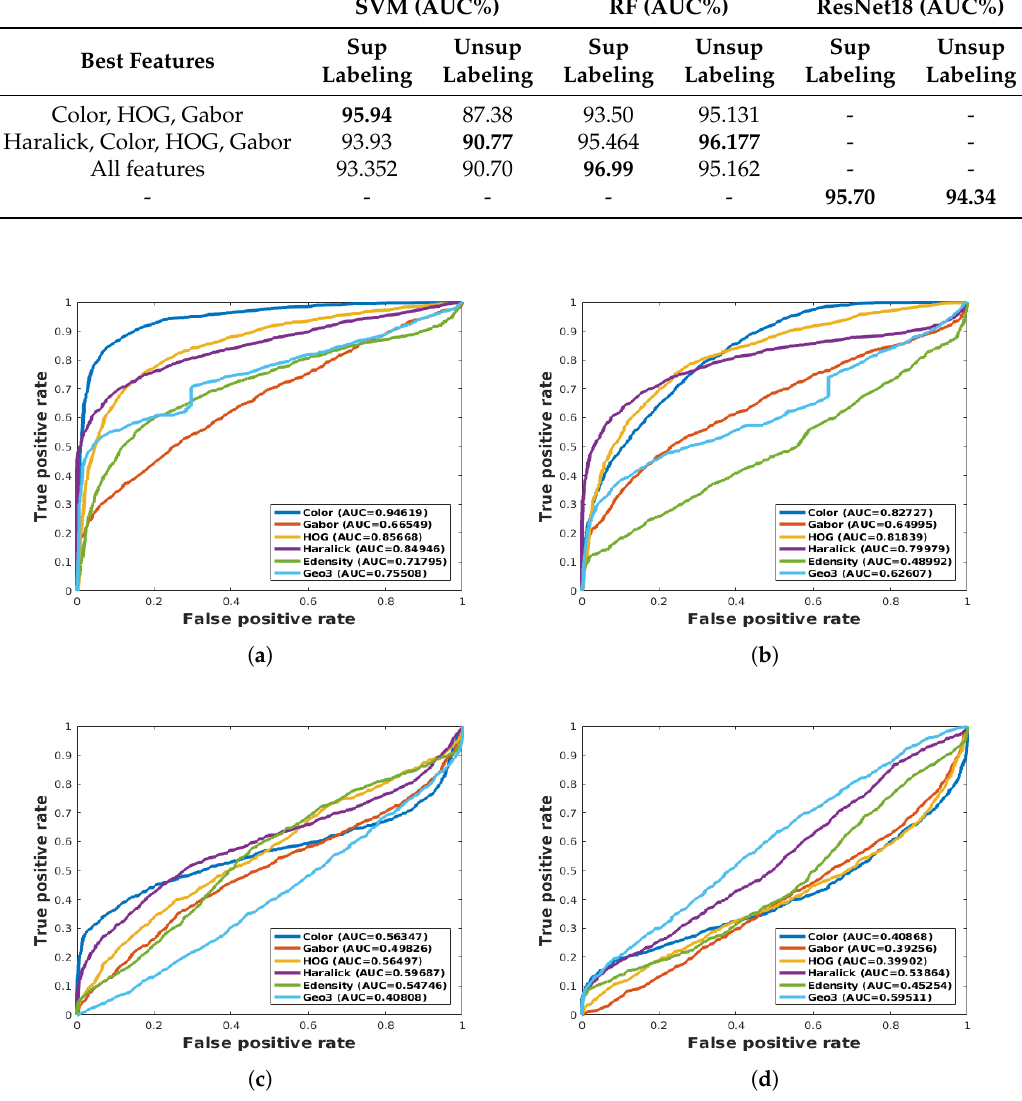
Figure 12. ROC curves of the SVM models created by each feature for each field. The first line represents the spinach field and the second one is the bean field. The first and second columns are the results of the models trained on the supervised and unsupervised data,